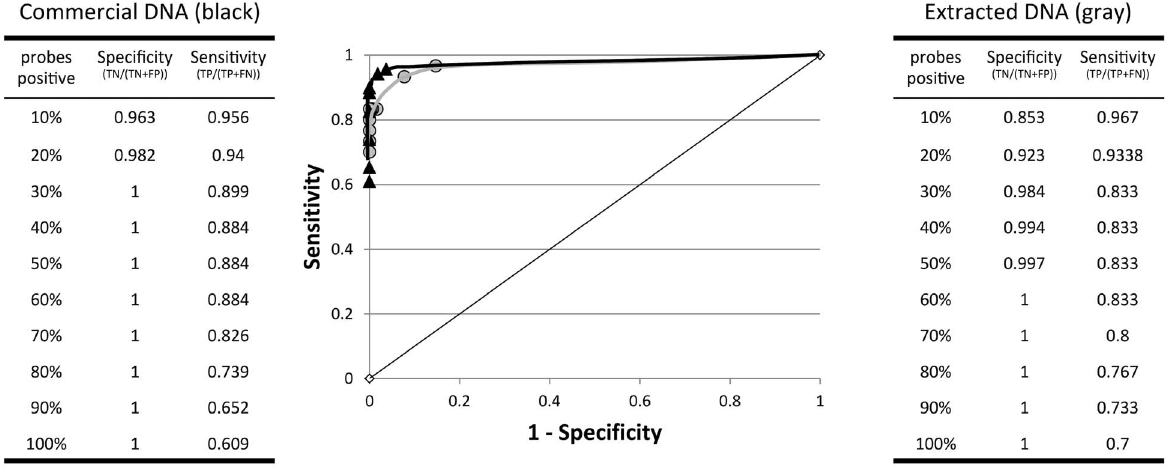
Figure 3. Receiver operating characteristic curves for reference strain data. Specificity and sensitivity data for commercial DNA preparations of sequenced strains (six strains; phenol-chloroform-extracted) are indicated in black. Analogous data for DNA preparations extracted in our laboratories are presented in gray (four strains). doi:10.1371/journal.pone.0069507.g003 used in this type of microarray. As a result, probes representing probes had at least three mismatches and all but two of the bla OXA-7 more distantly related alleles will be incorporated into future probes had at least two mismatches from the reference strain ARDM versions. Of the two false-negative alleles on the ARDM sequences. Given the overall high identity between the sequences that were . 90% identical to the reference strains, all of the tet(M) used to construct the ARDM and the reference strains, it is clear